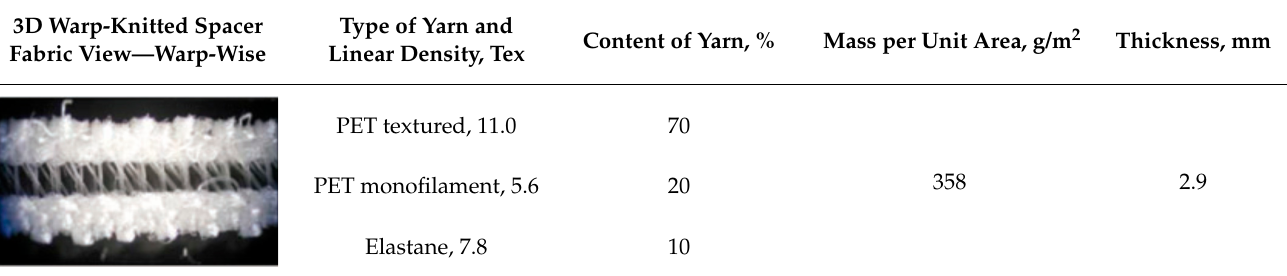
Table 1. Characteristics of 3D warp-knitted spacer fabric.